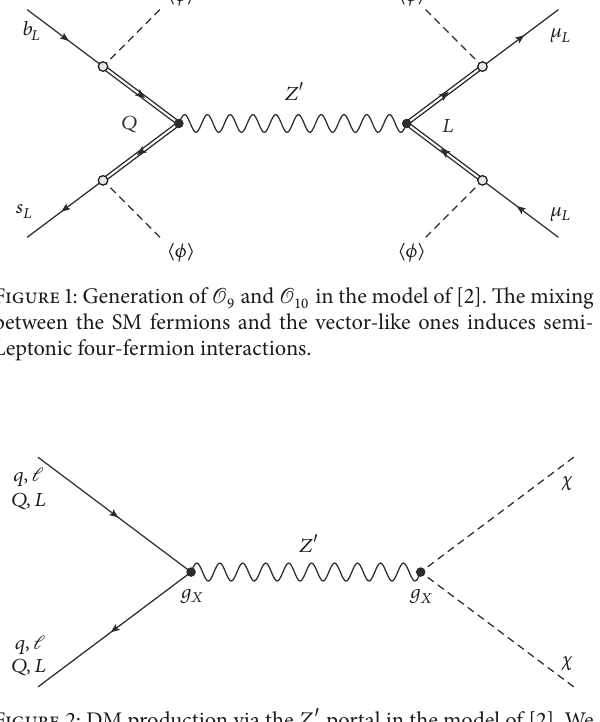
Figure 2: DM production via the 𝑍 耠 portal in the model of [2]. We notice that the vertex on the left of the diagram also participates in the explanation of the 𝑏 → 𝑠 anomalies (see Figure